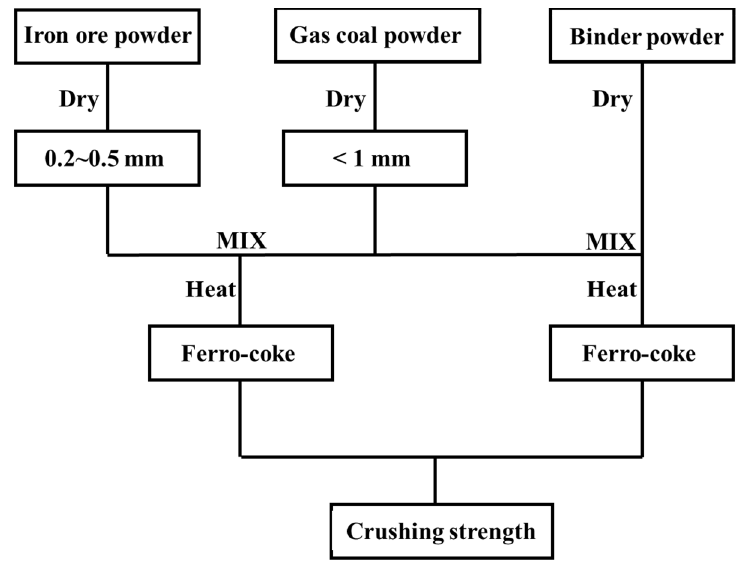
Figure 2. Experimental scheme.